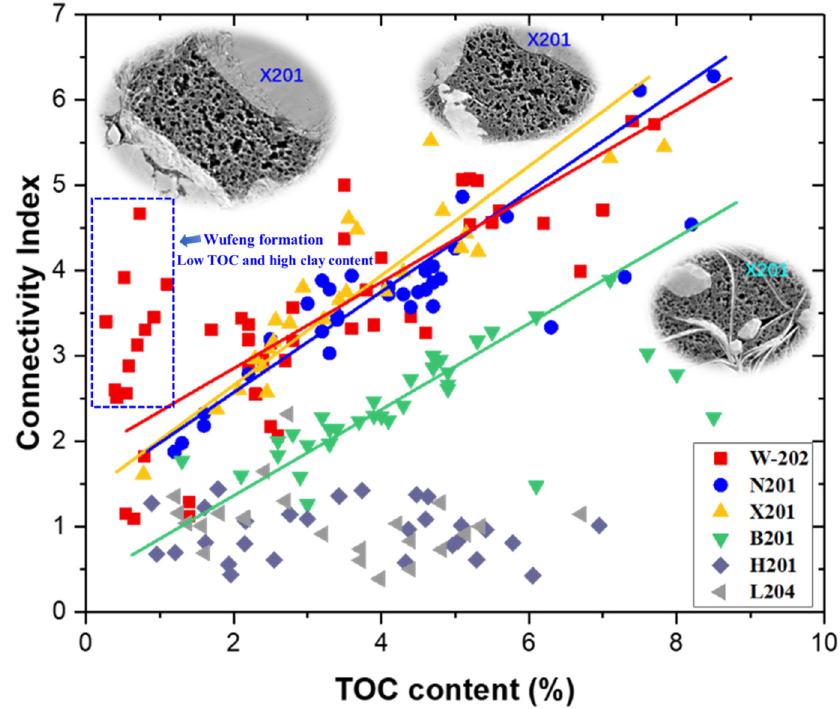
Figure 16. The influence on TOC content on the connectivity index.